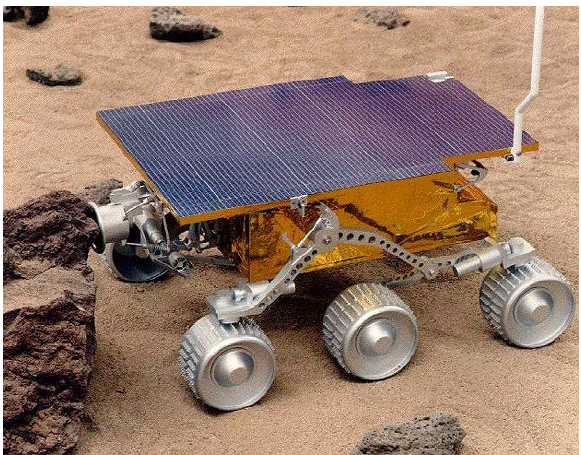
Figure 1. NASA’s Mars